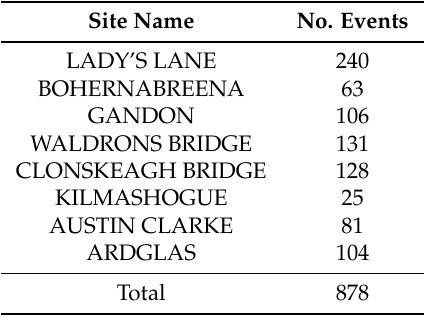
Table 6. Total number of events grouped based on the temporal information of the anomalies